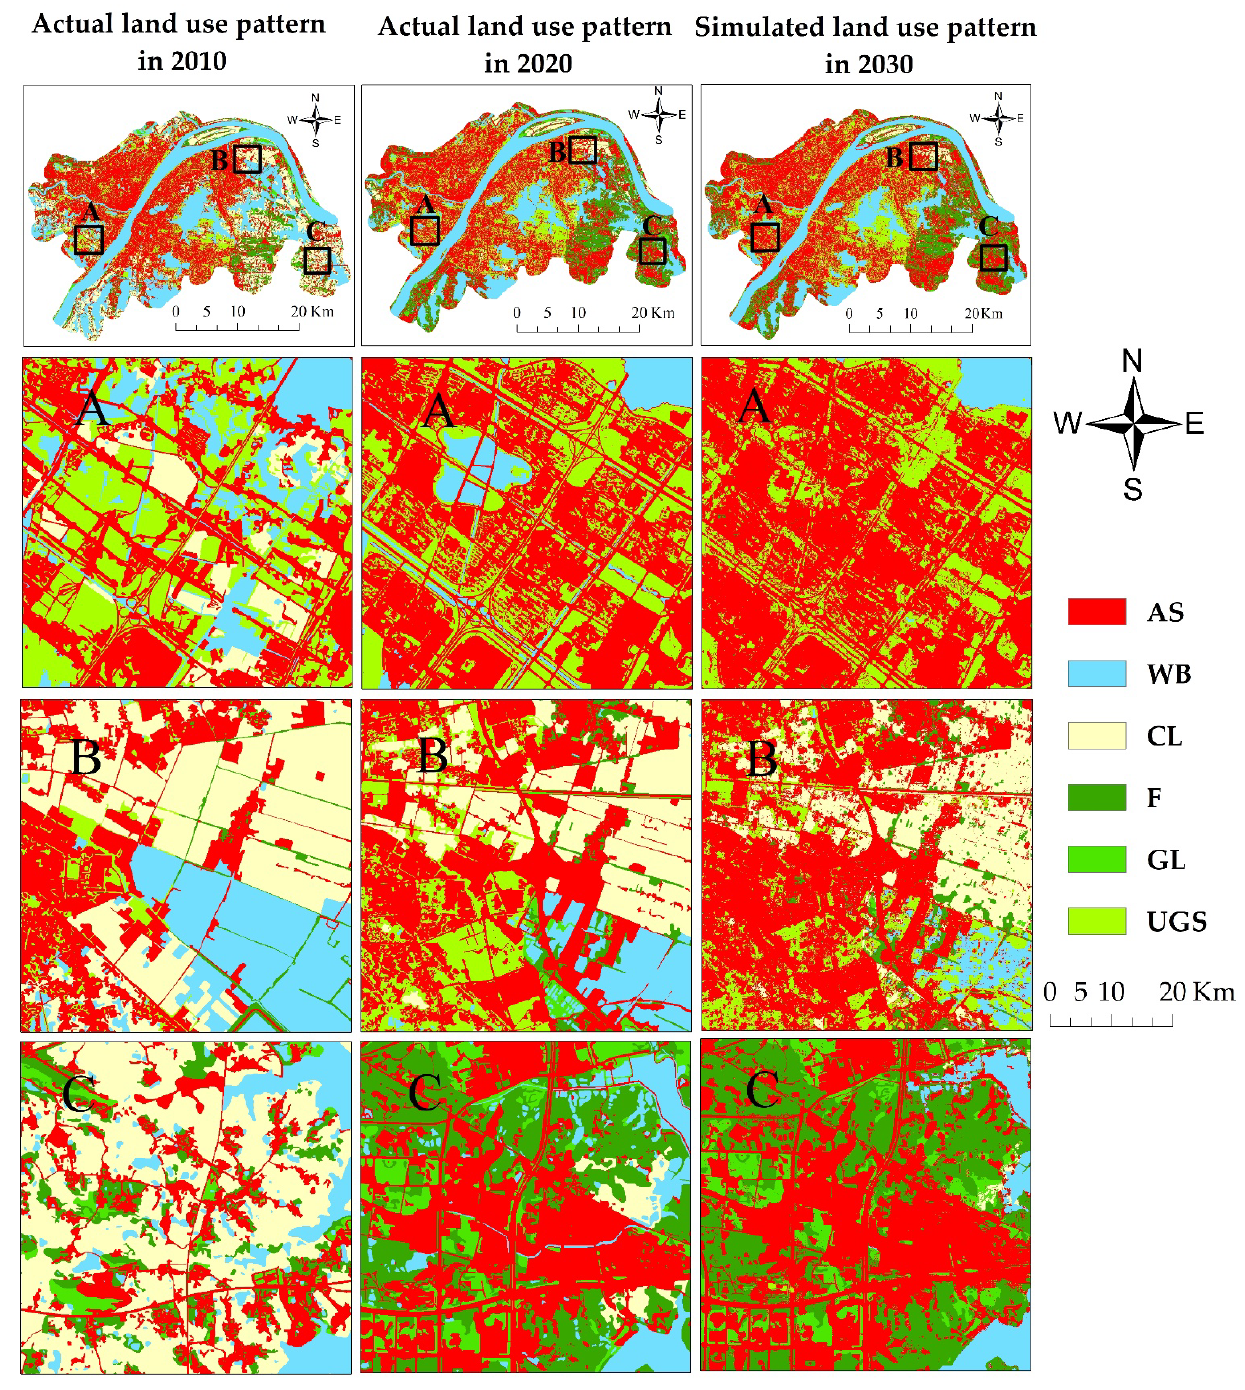
Figure 6. The spatial patterns of land use in Wuhan urban areas in 2010 (actual), 2020 (actual), and 2030 (simulated). The maps numbered ( A – C ) show zoomed in areas in the western, northern, and eastern parts of the study area, respectively.